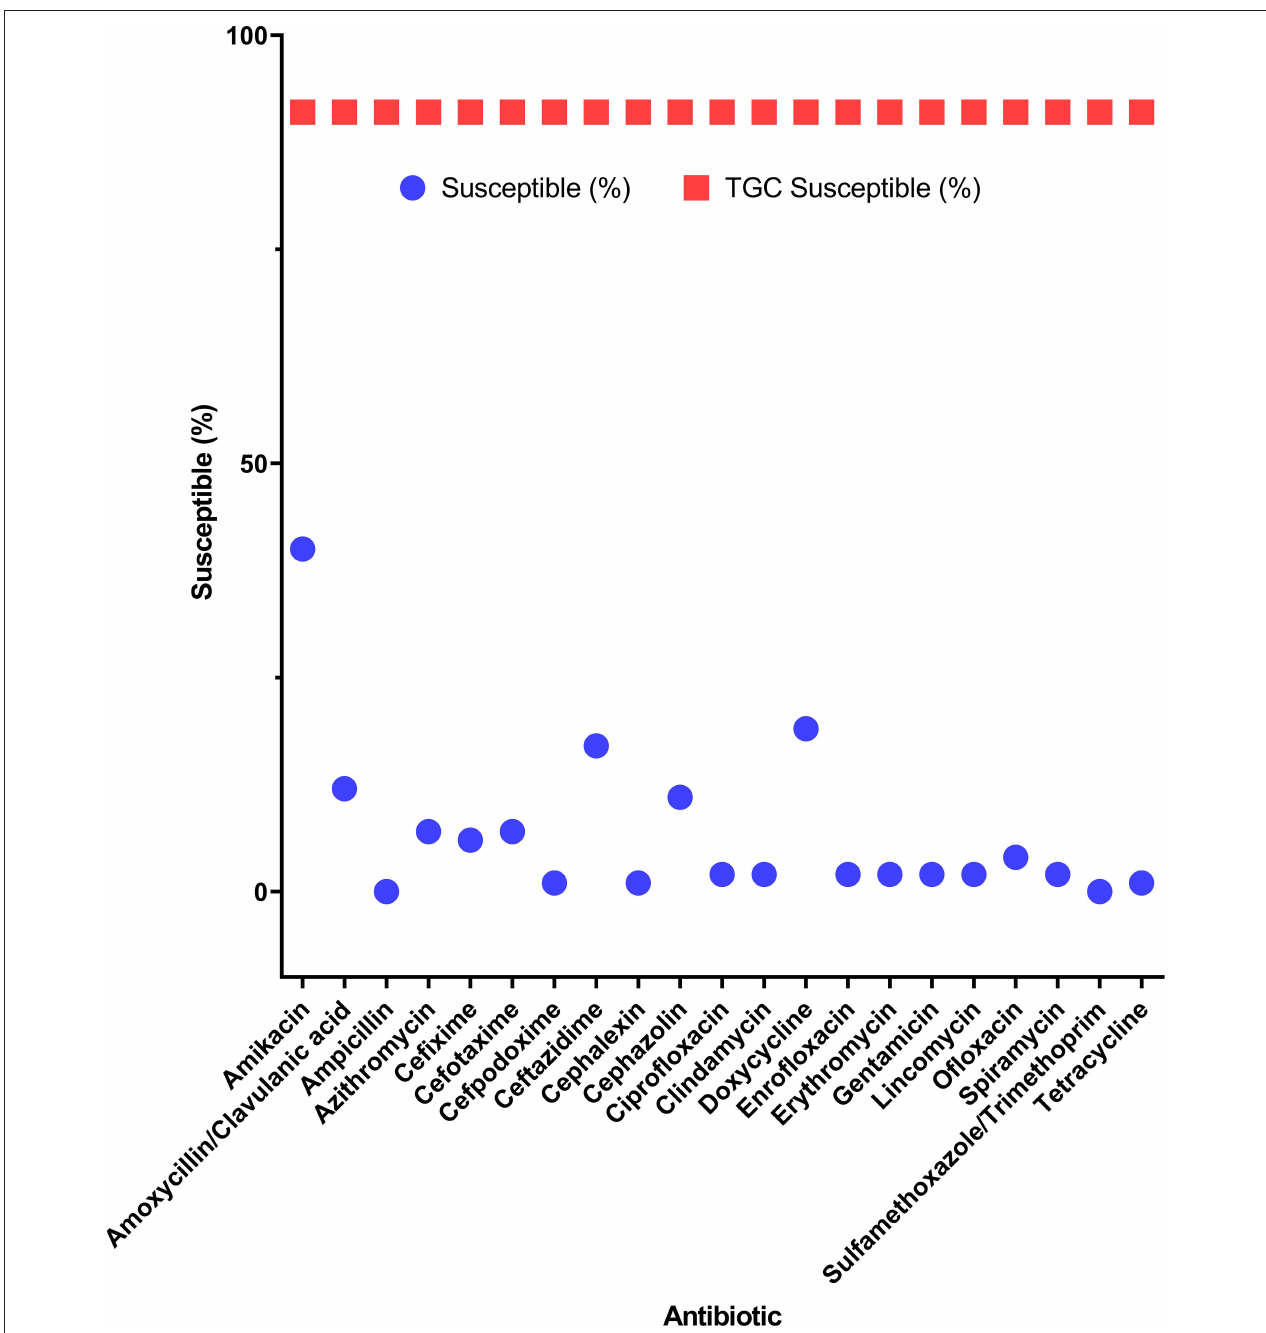
FIGURE 2 | Efficacy of tigecycline compared to 21 antibiotics for potential pan-drug-resistant (PDR) bacteria from dogs. Circles indicate the susceptibility of potential PDR isolates for each antibiotic. Squares indicate the average susceptibility of potential PDR isolates.